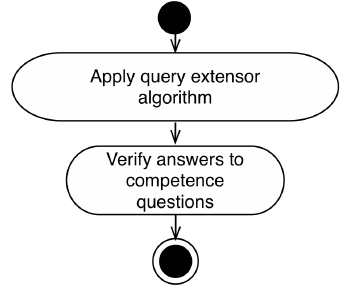
Figure 9. Overview of Query Test